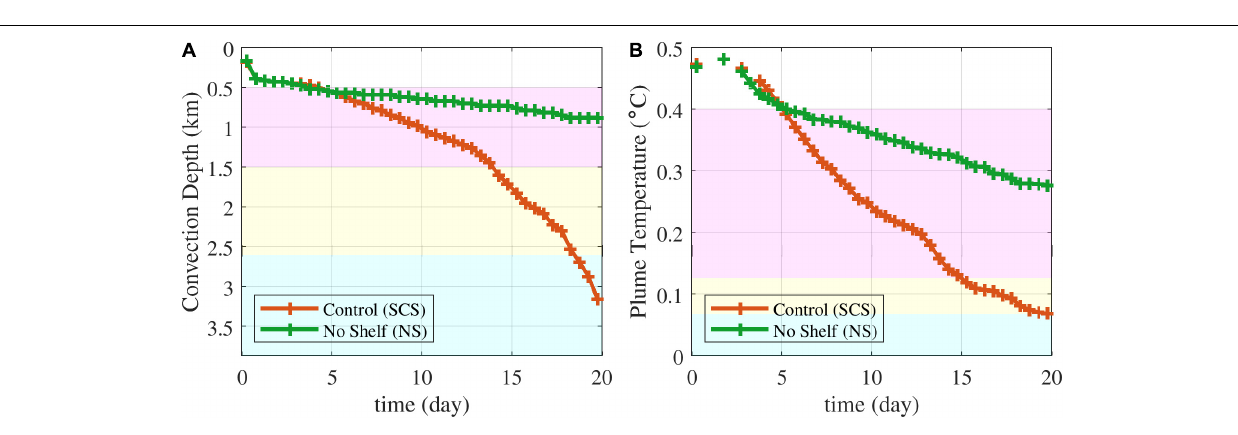
FIGURE 11 | (A) Depth and (B) potential temperature of the convective-plume head with time in the SCS and NS